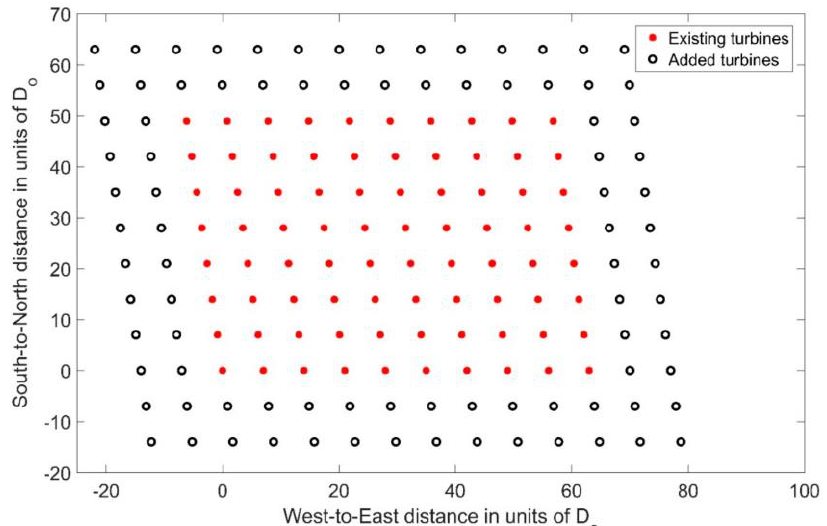
Figure 9. Upgrade layouts for a wind farm with an external grid [107].